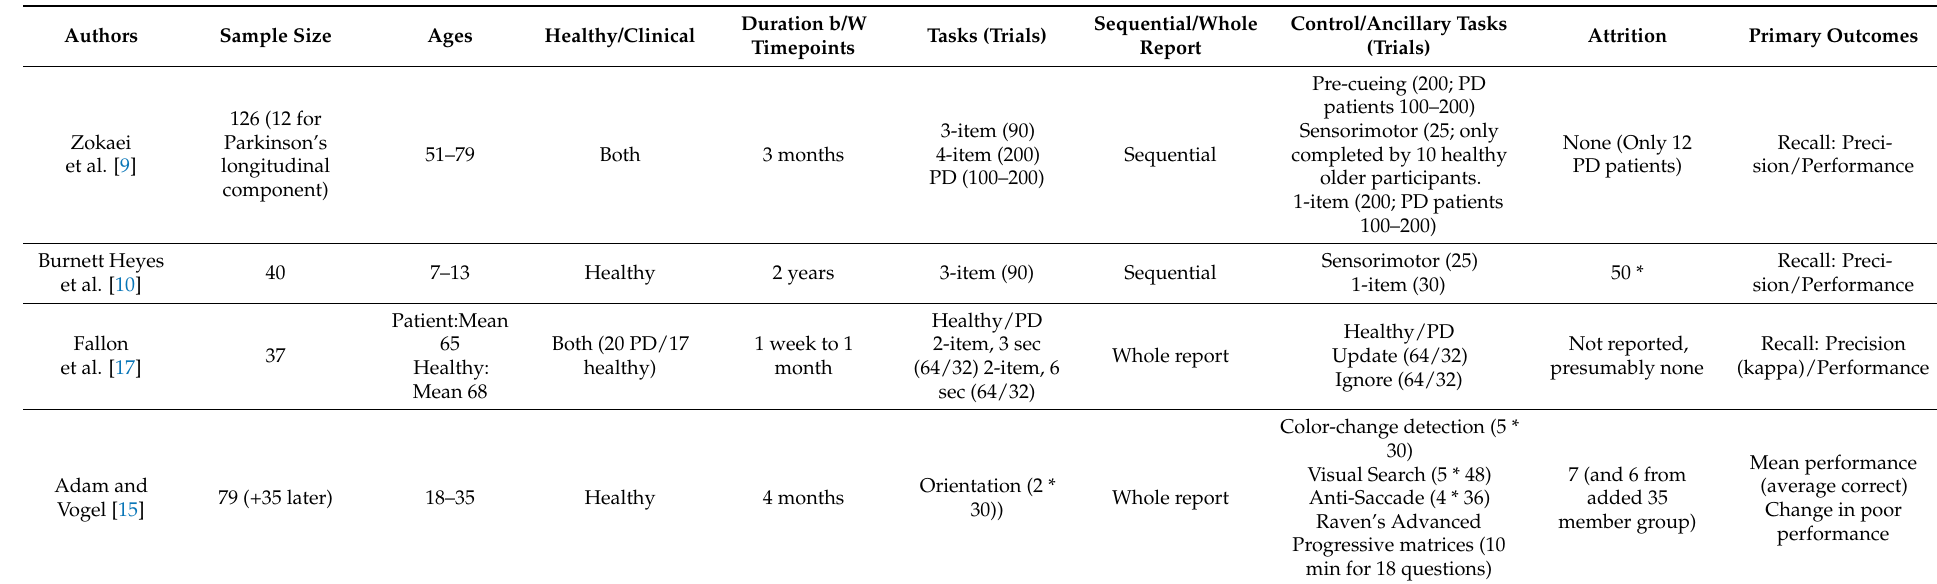
Table 2. Collation of the various study criteria that could affect the interpretation of outcome